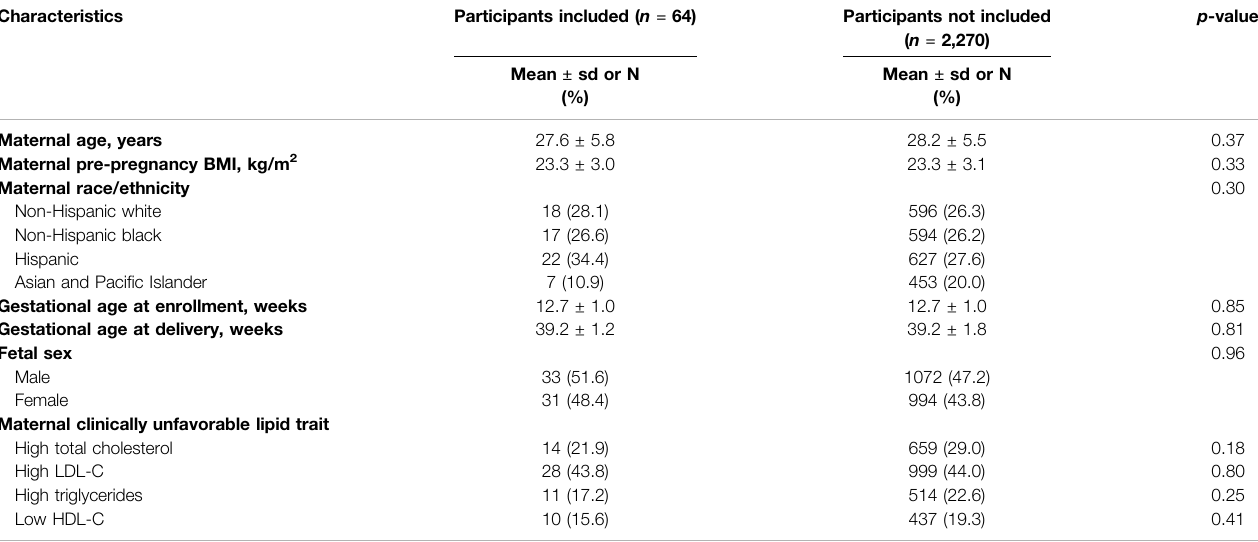
TABLE 1 | Characteristics of the study subsample ( n (cid:1) 64) compared to the remaining samples not included in the present study from the NICHD fetal Growth Studies – Singletons (total n (cid:1) 2,334).